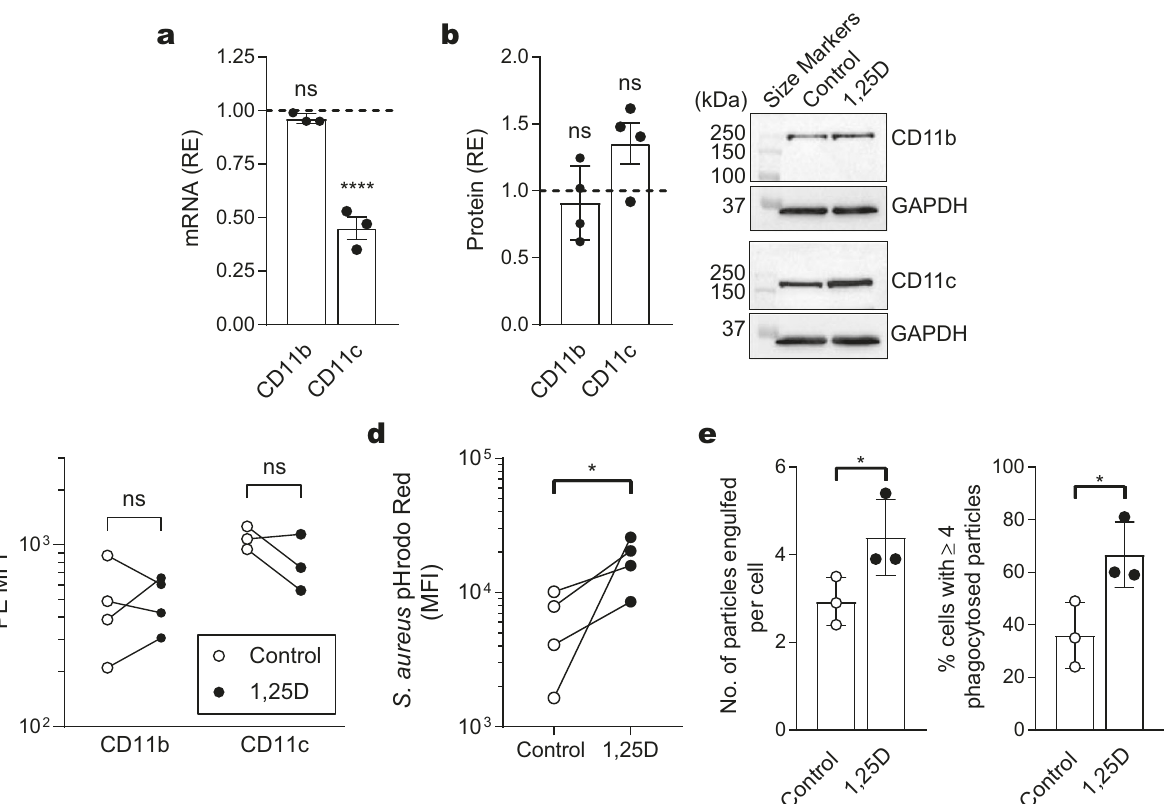
Fig. 2 Effect of 1,25D on macrophage CR3 and CR4 expression and phagocytosis. Monocytes were cultured for either 3 days (for mRNA expression) or 5 days (for protein expression) with 1,25D and examined for complement receptor expression. Relative expression (RE) of mRNA or protein was measured against GAPDH. a Macrophages were examined for CD11b and CD11c mRNA expression. Data are expressed as fold-change compared with untreated control from three experiments each conducted with cells from a different individual and expressed as mean ± s.d. b Macrophages were examined for CD11c and CD11b protein expression by western blotting, normalized against GAPDH from four experiments each with cells from a different individual. Representative western blots are shown. c Macrophages were analysed for CD11b and CD11c surface expression by fl ow cytometry. The PE MFI values are shown of four (CD11b) and three (CD11c) experiments, each conducted with cells from a different individual. d Phagocytosis of S. aureus bioparticles by macrophages as measured by the pH-sensitive pHrodo ™ Red dye. Data are expressed as MFI, each conducted with cells from a different individual. e Phagocytosis of opsonized C. albicans by macrophages derived from monocytes cultured in either the presence or absence of 100 nM 1,25D for 5 days, is expressed as the number of engulfed particles per cell (left graph) and the percentage of cells with four or more phagocytosed particles (right graph). Data are presented as mean ± s.d. of three experiments each with cells from a different individual. a , b Data are presented as mean ± s.d. P values were calculated using one-way ANOVA followed by Dunnett ’ s multiple comparison test. c – e P values were calculated using paired two-tailed ( c ) or one-tailed ( d , e ) Student ’ s t -test. Signi fi cance of differences between 1,25D versus control, * P < 0.05, **** P < 0.0001, ns = not signi fi